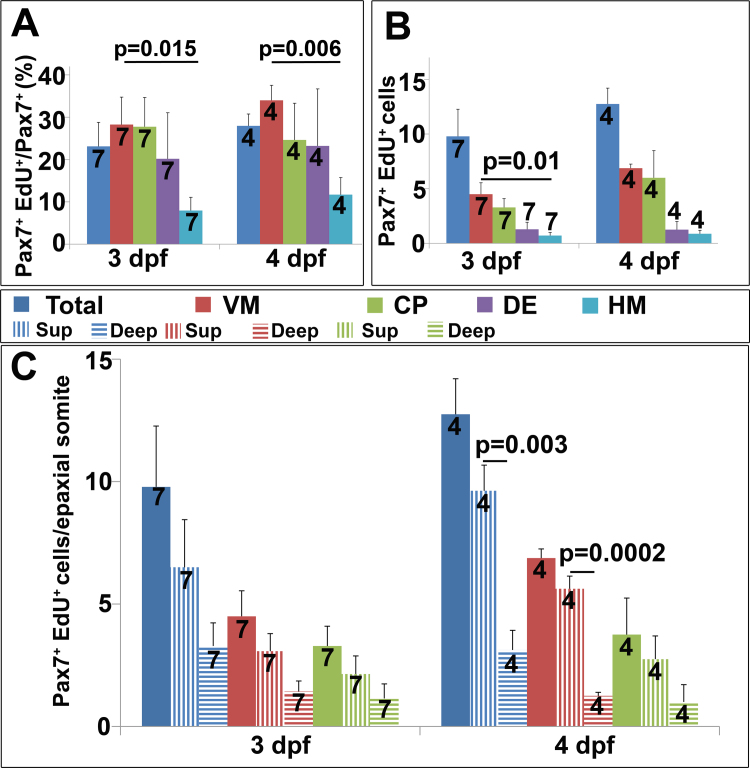
Location of Pax7+ cell proliferation. A: The fraction of Pax7+ cells labelled with EdU is similar in most somitic domains. B: Paralleling the higher Pax7+ cell numbers, slightly more proliferative Pax7+ cells were detected at VM than HM (compare values with Fig. 3D and S2A). C: Pax7+ cells in both deep and superficial VM and CP proliferate similarly (compare values with Fig. 3C,D).